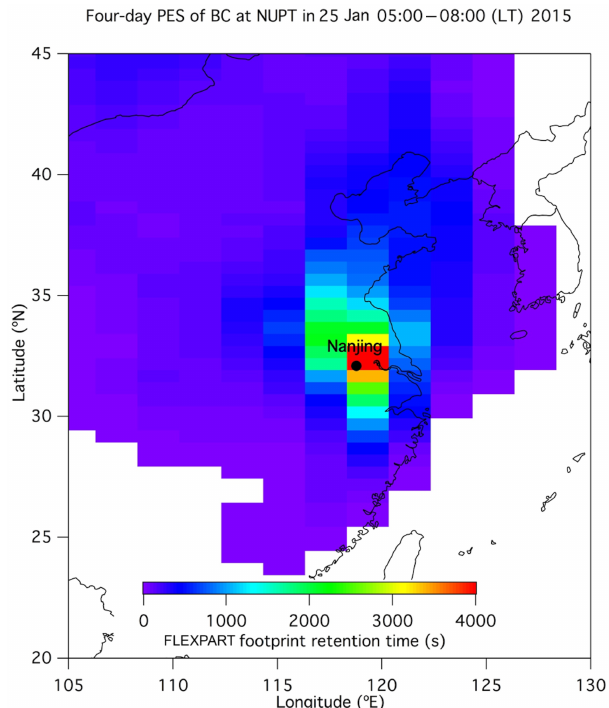
Figure 8. The four-day footprint of NUPT (32.09 ◦ N, 118.78 ◦ E, black point), the observation site, starting from 05:00–08:00LT on 25 January 2015 when the maximum levoglucosan was observed. The footprint was illustrated as FLEXPART potential emission sen- sitivity, shown as the retention time in each grid at 0–500m con- tributing to the observed elemental carbon.